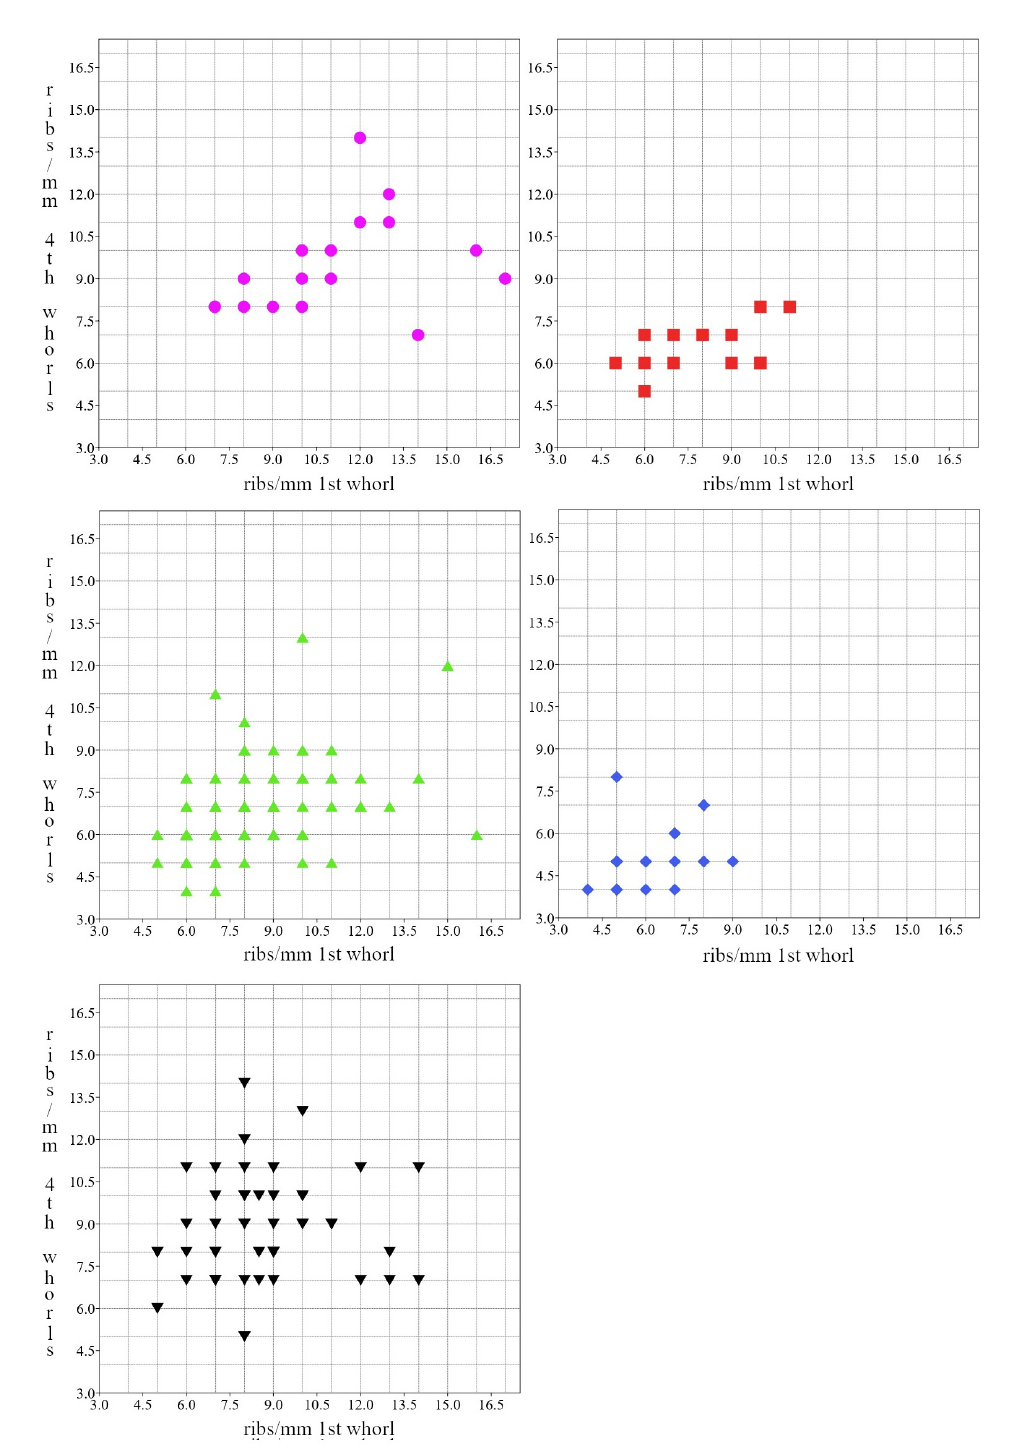
Fig. 11. Ribs per mm on the 1 st whorl vs ribs on the 4 th whorls of the species in Clessiniella Zallot et al ., 2015. Violet dots = Cochlostoma ( Clessiniella ) anomphale Boeckel, 1939; red squares = Co. ( Cl. ) stelucarum sp. nov.; green triangles = Co. ( Cl. ) tergestinum (Westerlund, 1878); blue diamonds = Co. ( Cl. ) villae (Strobel, 1851); black triangles = Co. ( Cl. ) waldemari (A.J. Wagner, 1897). Analysis performed with the software ‘Past’